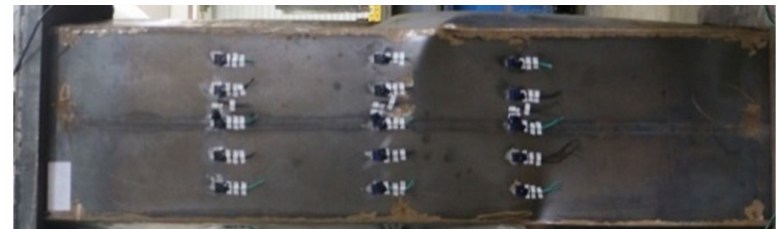
Figure 8. Buckling failure of the